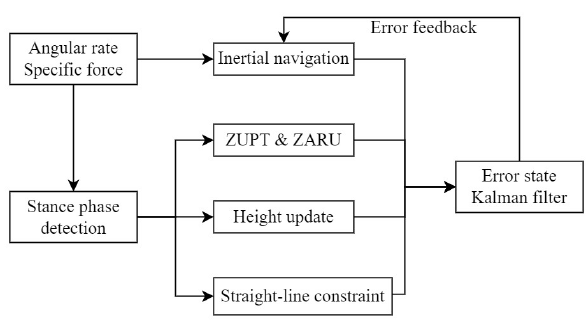
Figure 2 . Operation Mode of WearTrack.